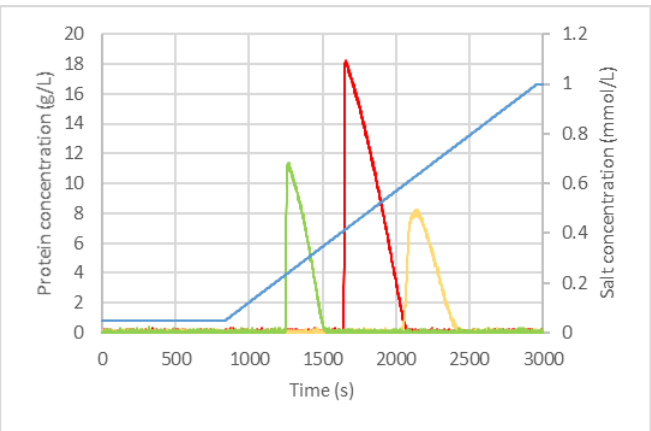
Figure 6. The initial noisy chromatogram before the separation performance decreases. The green curve shows HCP1, the red curve IgG, the yellow curve HCP2 and the blue curve shows the salt gradient.